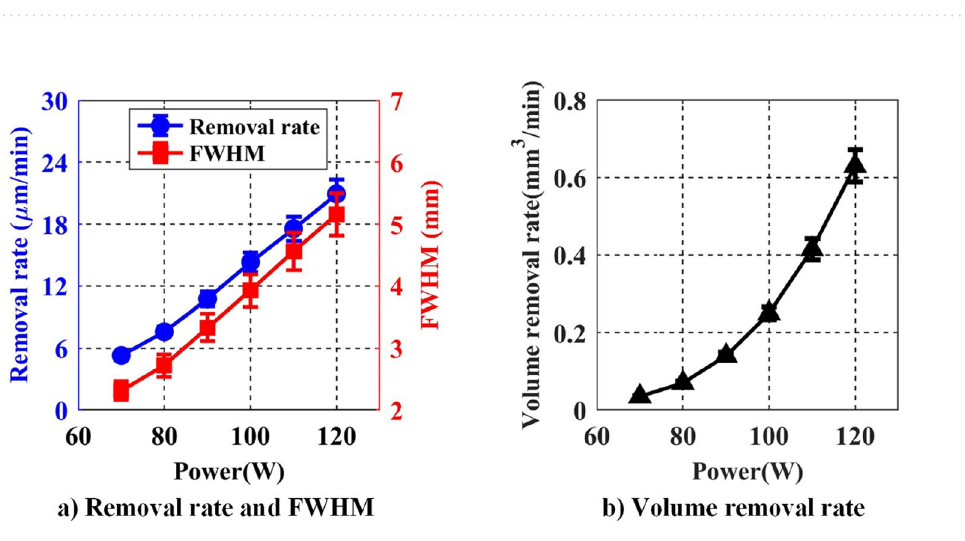
Table 5. RF power as processing variable.